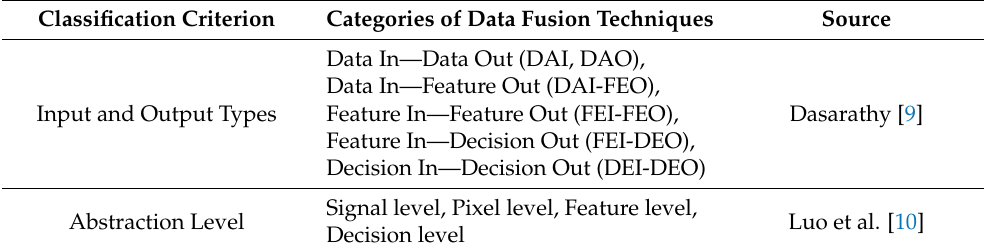
Table 1. Categorization of data fusion techniques based on classification criteria found in the